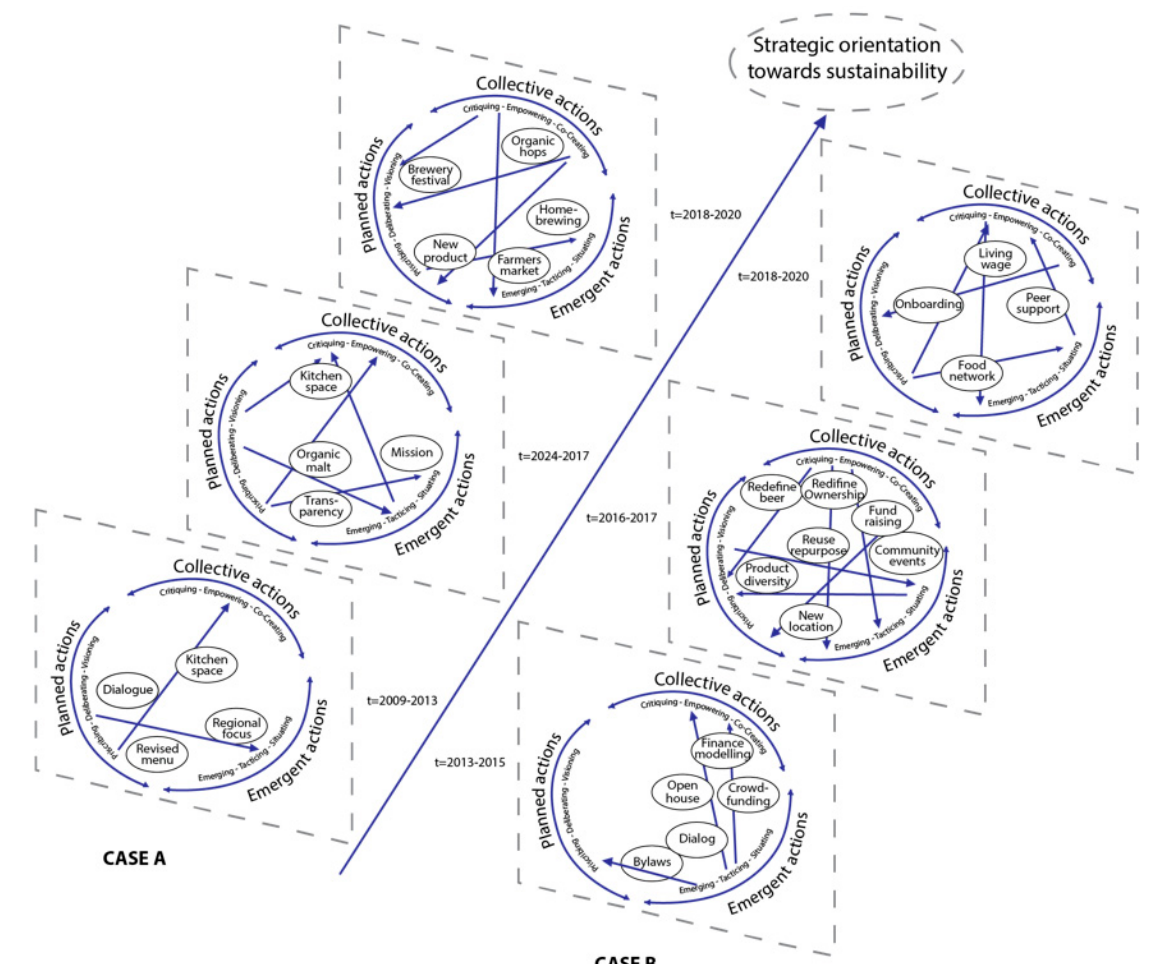
Figure 5. Integrated Activity-based Model (reproduced with permission from [76]